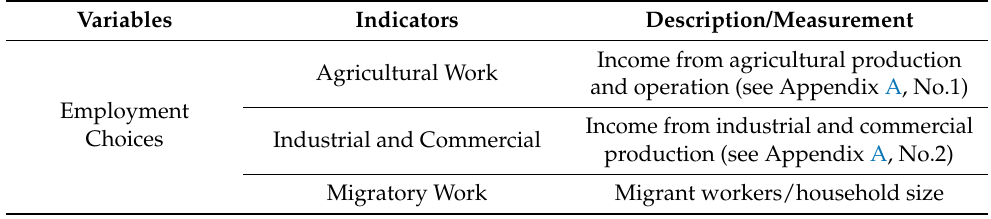
Table 1. Mediating variables and dependent variables and indicators.